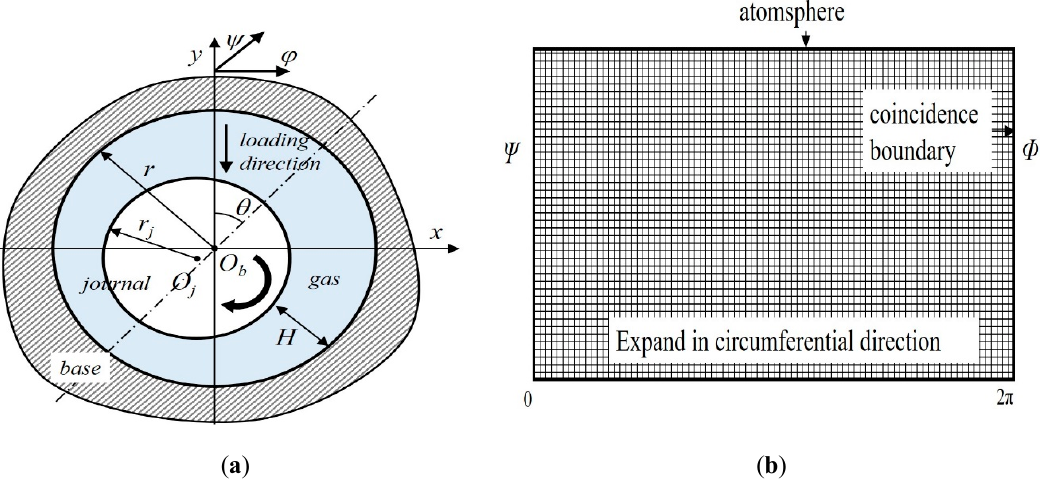
Figure 1. Geometry and mesh of a typical gas-lubricated microbearings ( a ) geometry of bearing; ( b ) mesh of the finite element model (FEM).